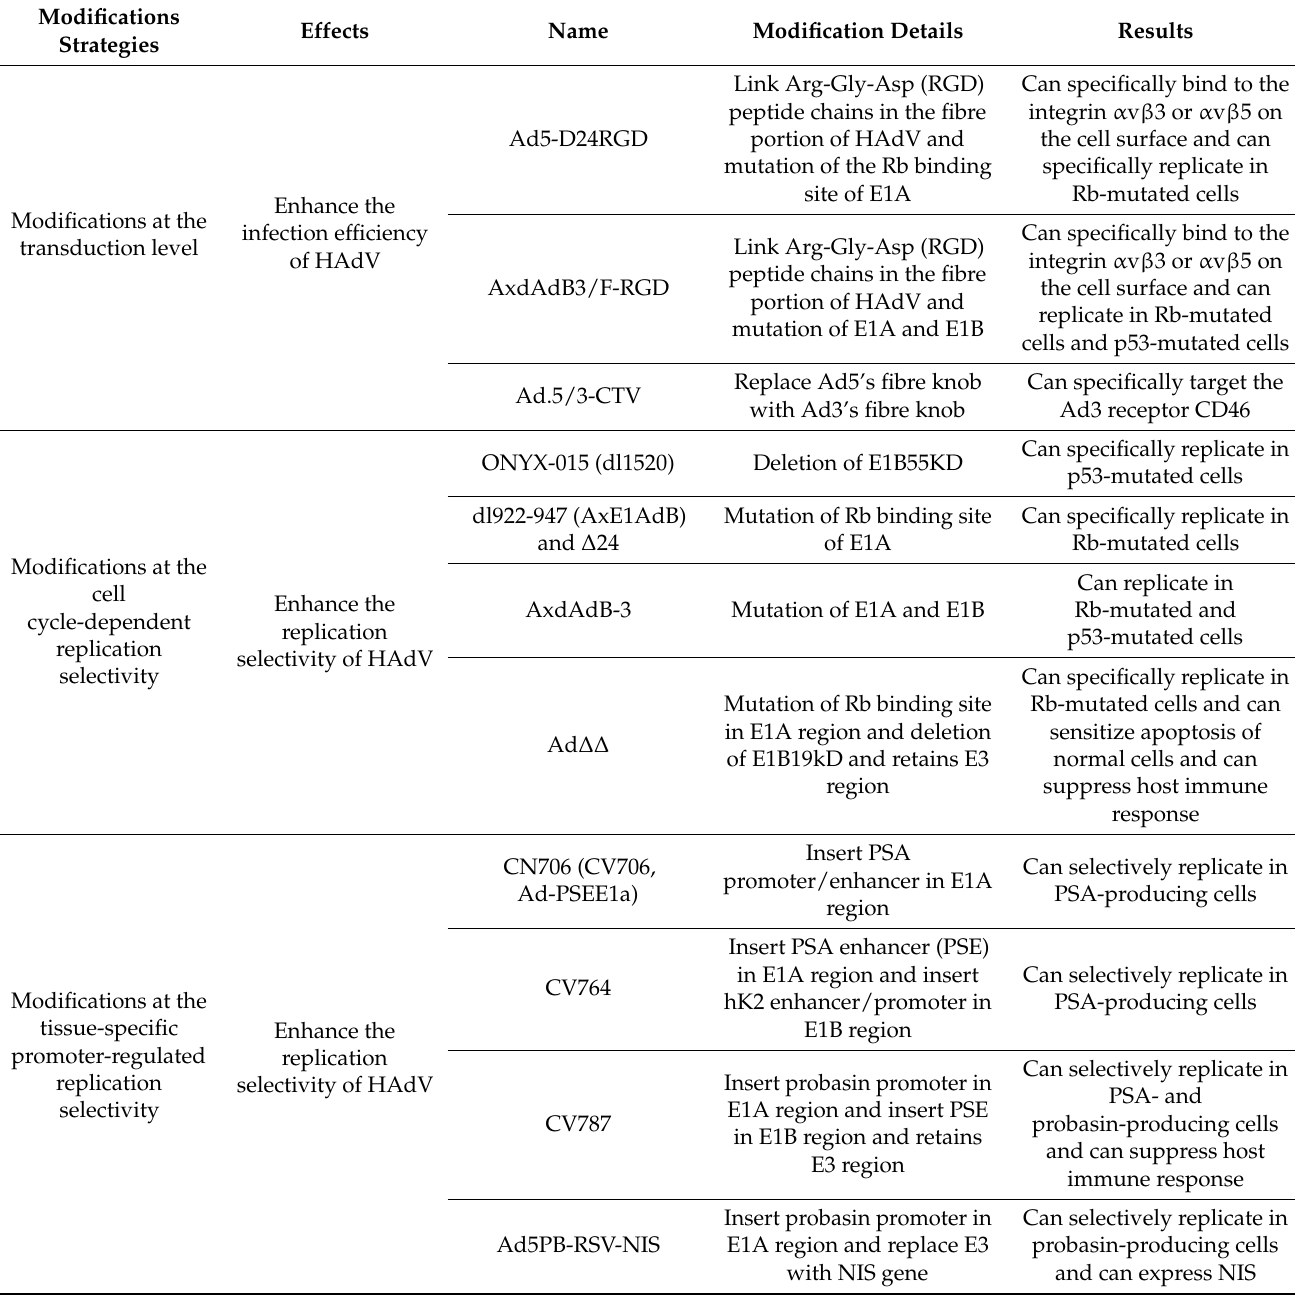
Table 2. Modification strategies and preclinical experiments of some oncolytic